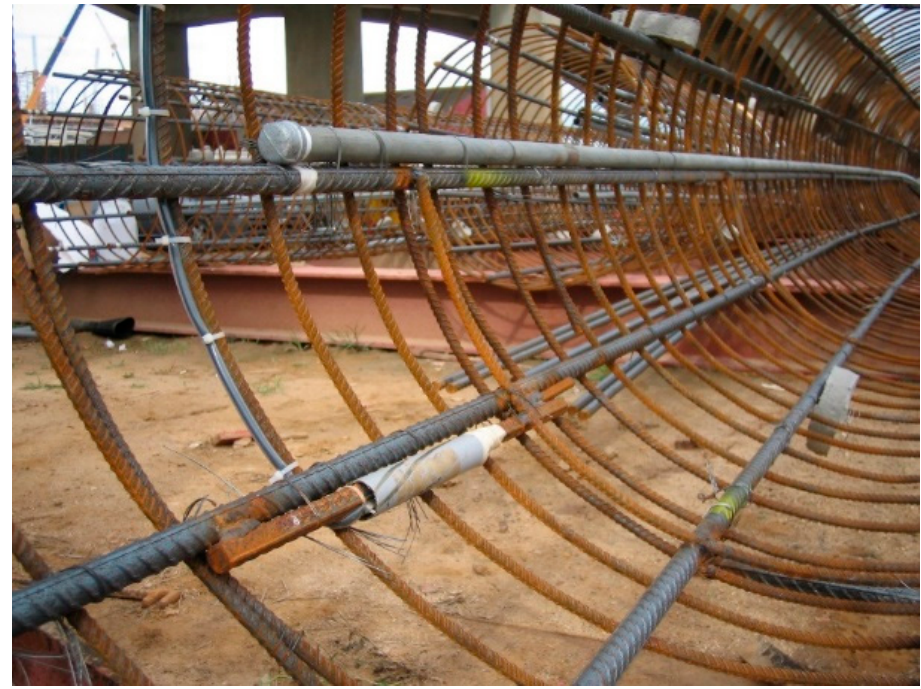
Figure 9. global strain extensometer pipe for tell-tales extensometer is pre-installed at VWSG.